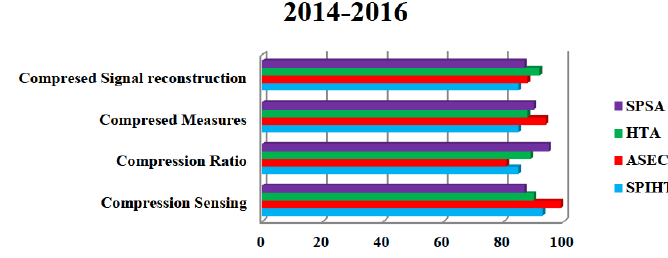
Figure 4: Graphical representation of 2017-2018 review papers